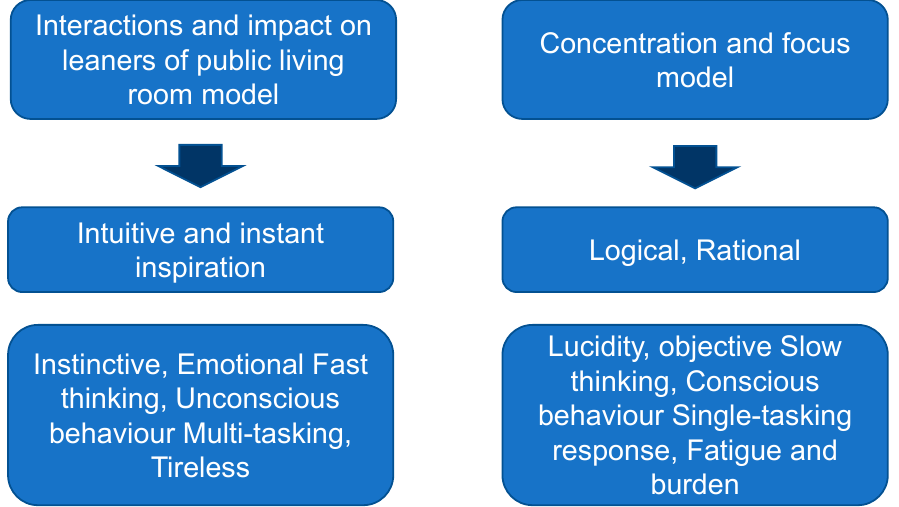
Figure 12. A comparative image between the ‘public living room’ model and ‘focus model’.